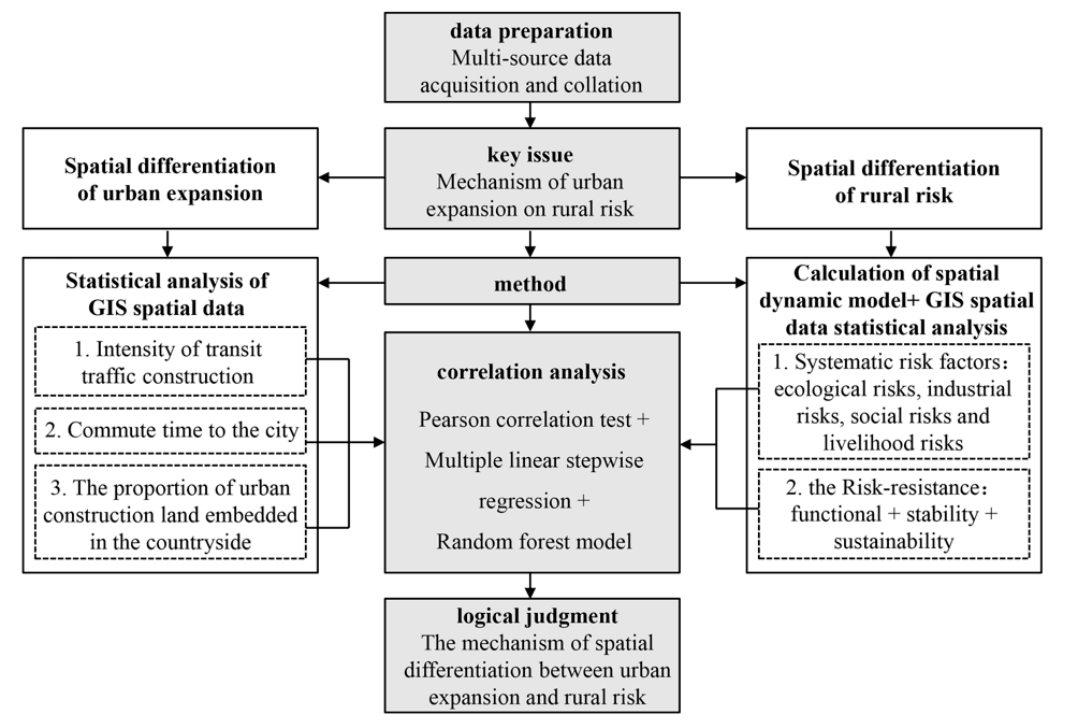
Figure 2. Research framework of spatio-temporal differentiation and mechanism of rural systemic risk under the influence of urban expansion (source: